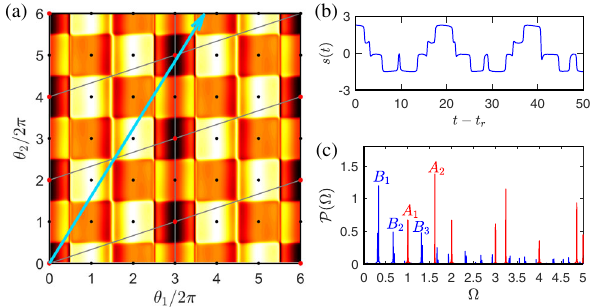
FIG. 6. Z 3 × Z 2 DTQC with the model and observable detailed in Appendix D 2. (a) Observable s ð θ Þ in θ space at leading order in inverse frequency, displaying the symmetry-breaking pattern lattice L (red points) as well as the original lattice of SSB translations L (black points). Grey boxes denote the sym- metry-breaking unit cell. (b) Discrete time quasicrystal response s ð t Þ ¼ s ð ω t Þ . (c) Power spectra P ð Ω Þ of both the driving function (red) and the observable s ð t Þ (blue). Dominant peaks in the driving function correspond to Ω ¼ ω 1 ( A 1 ) and Ω ¼ ω 2 ( A 2 ). Dominant peaks of the observable s ð t Þ correspond to Ω ¼ ω 1 = 3 ( B 1 ), Ω ¼ 2 ω 1 = 3 ( B 2 ), Ω ¼ ð ω 1 þ ω 2 Þ = 2 ( B 3 ). Going beyond leading order in inverse frequency, an observable ’ s power spectrum can exhibit peaks at frequencies Ω ¼ n 1 ð ω 1 = 3 Þ þ n 2 ½ − ð ω 1 = 6 Þ þ ð ω 2 = 2 Þ(cid:3) for n 1 , n 2 ∈ Z .